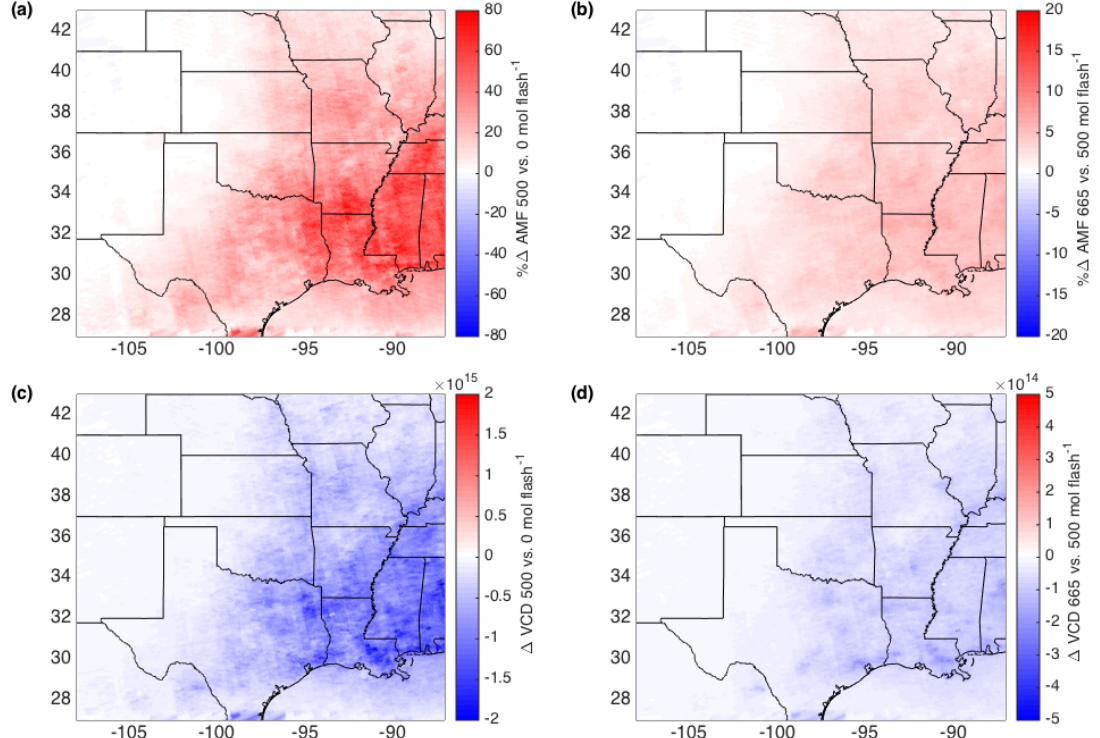
Figure 6. Average percent difference in AMFs (a, b) and absolute difference in VCDs (c, d) averaged over the time period 18 May–23 June 2012. (a, c) Difference between profiles generated using 500 and 0molNOflash − 1 ; (b, d) difference between profiles generated using 665 and 500molNOflash − 1 . Note that in panels (c) and (d) the color scale is one-fourth that of panels (a) and (b)